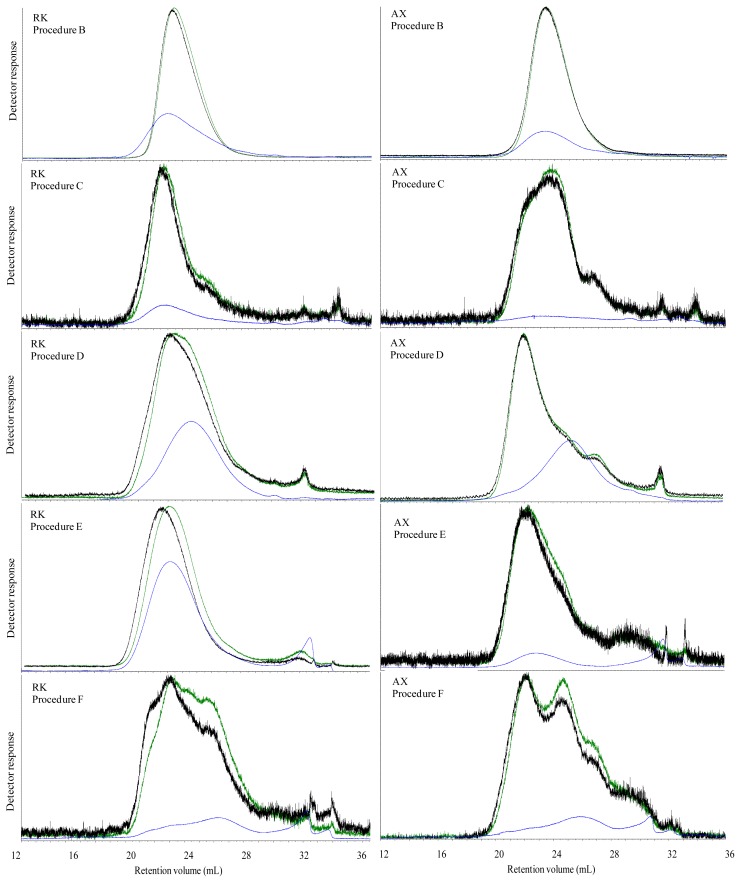
Size exclusion chromatography with RALLS (green), LALLS (black) and intrinsic viscosity (blue) signal of extracts of water extracted (procedure B), in vitro digested (procedure C), in vivo digested (procedure D) and lichenase treated in vitro digested (procedure E) and lichenase treated in vivo digested (procedure F) RK and AX breads.